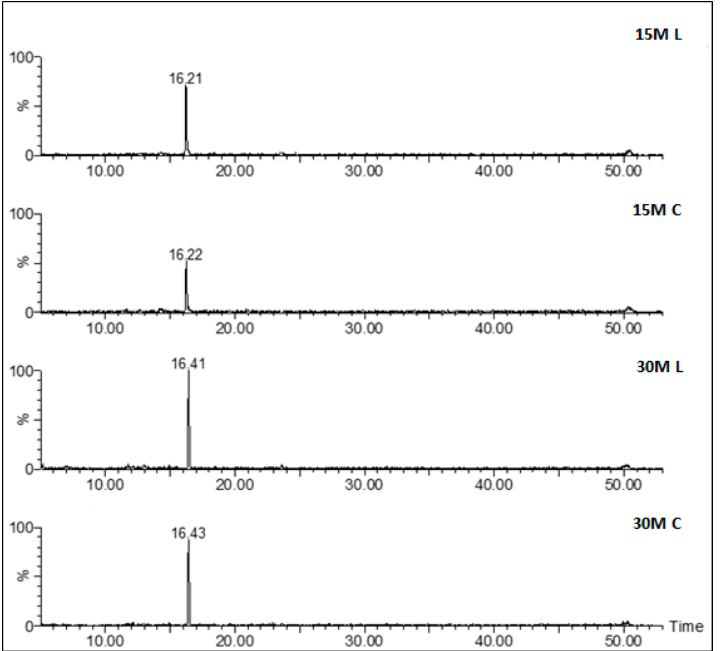
Figure 4. Examples of extract ion chromatograms obtained from full-scan chromatograms (Figure 3) by extracting the characteristic ions of the compound Lactoyl-Met (m/z 222) in one sample of each set.